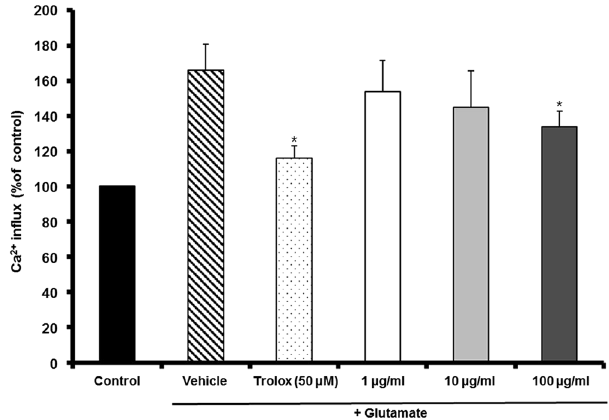
Figure 3. The effect of MF extract on glutamate-induced Ca 2 + influx in HT22 cells. Results are expressed as percentages of the values of control cells. * p < 0.05 vs. glutamate-treated cells.